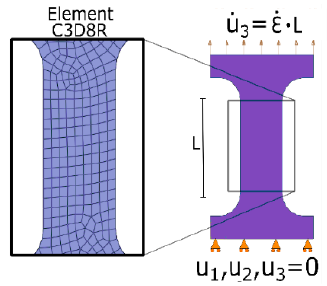
Figure 6: Mechanical boundary conditions in the FE simulation.